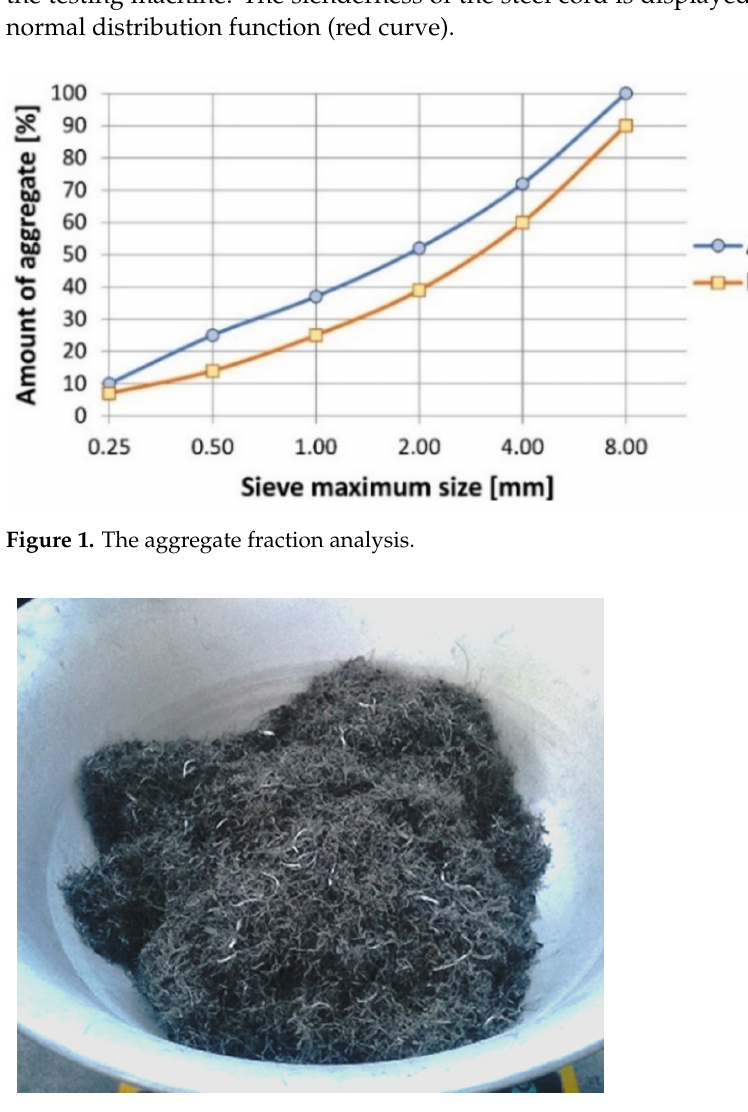
Figure 2. Recycled steel fibers used in the investigation. Table 1. Mix composition.